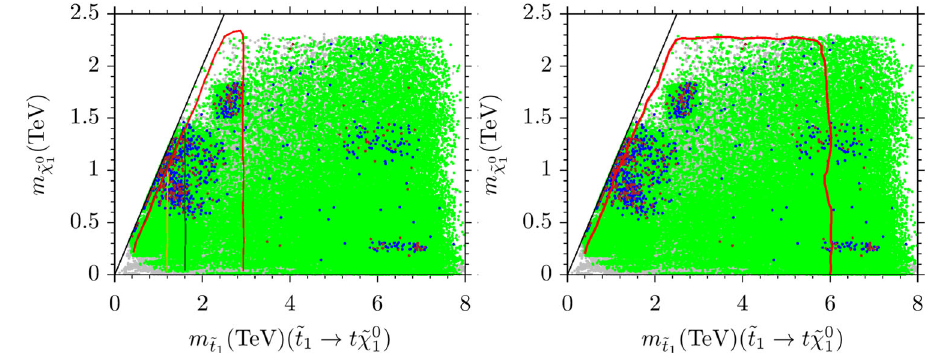
Fig. 7 Exclusion curves for the stop mass through ˜ t 1 → t ˜ χ 0 color coding is the same as in Fig. 2. In the left panel, orange curve represents the exclusion at the current energy, while the dark green and red are obtained at 27 TeV and 100 TeV, repsectively. Luminosity is